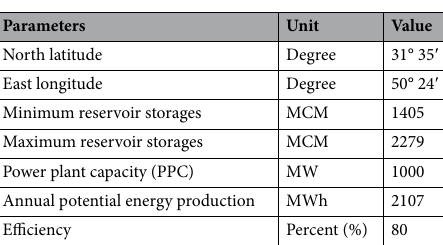
Table 1. Characteristics of the Karun-4 hydropower